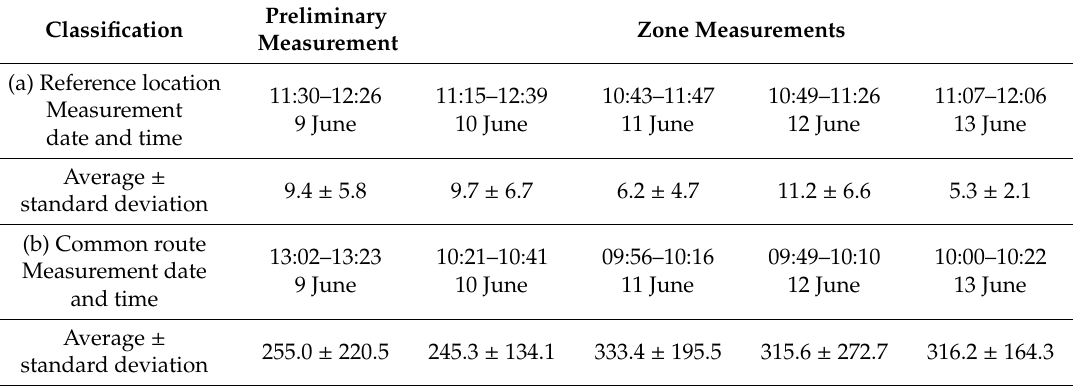
Table 2. Date and time of measurements and the pPAH concentrations at (a) the reference location and (b) the common route (unit: ng / m 3